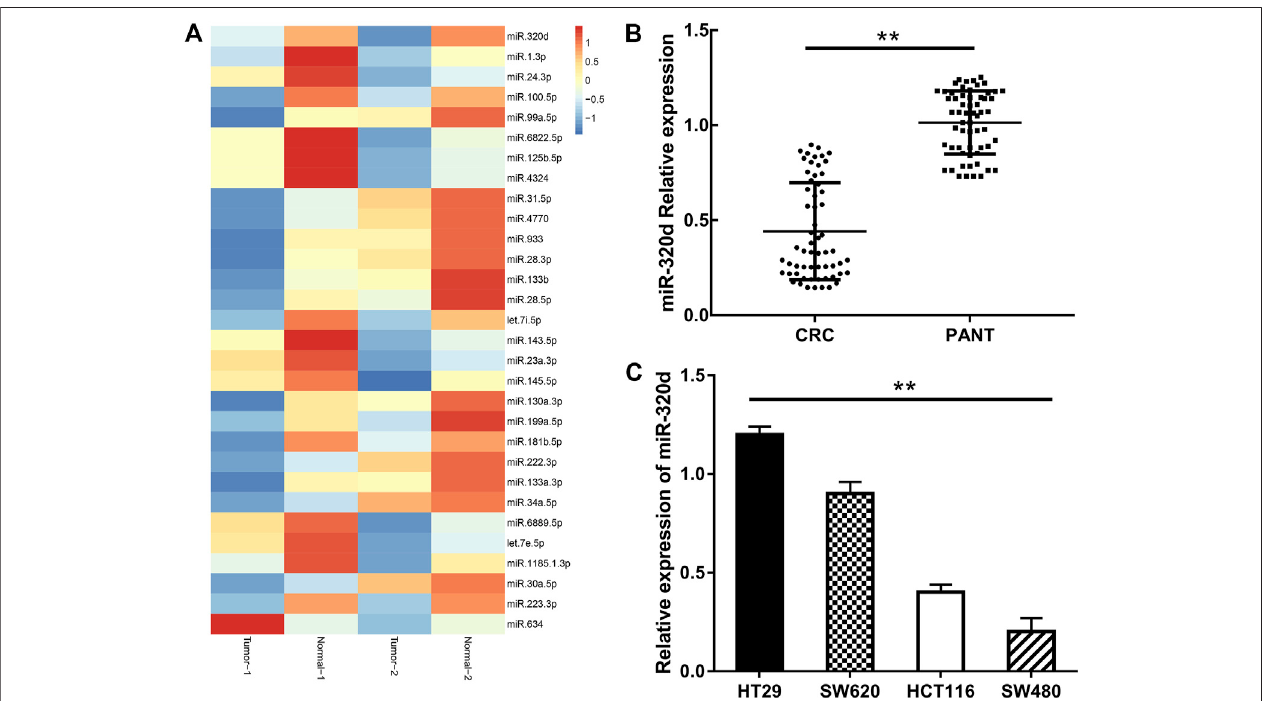
FIGURE 1 | The expressions of miR-320d were examined in the EGFR-positive colorectal cancer and cell lines. (A) The heatmap of the top 30 differentially expressed microRNA in EGFR-CRC and paired adjacent normal tissue. Each column represents a sample, and each row represents the expression level of a given microRNA. The color scale represents the raw Z score ranging from blue (low expression) to red (high expression). (B) qRT-PCR analysis of miR-320d in EGFR-positive CRC tissues ( n (cid:1) 60) and adjacent normal tissues ( n (cid:1) 60). (C) qRT-PCR analysis of miR-320d in EGFR-positive CRC cell lines. Statistical analysis was conducted using Student ’ s t test. ** p <